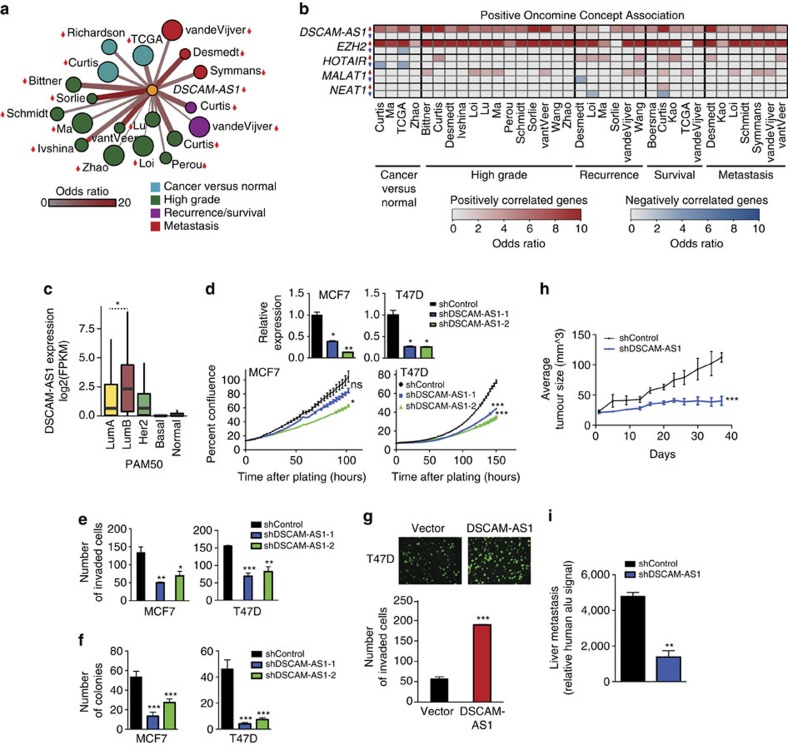
DSCAM-AS1 is implicated in cancer aggression clinically and in cell lines.(a) Cytoscape depiction of the overlap between the 150 genes most positively correlated with DSCAM-AS1 and clinical signatures from Oncomine27 for breast cancer clinical outcomes (i.e., recurrence, survival and metastasis), high cancer grade, and cancer versus normal. All significant associations with an odds ratio >6 are shown (Fisher's P value <1E−4). Size of node reflects the size of the gene signature, and the thickness/redness of the line represents the magnitude of the odds ratio. (b) Heatmap displaying the overlap between the top 150 genes correlated to DSCAM-AS1, EZH2, HOTAIR, MALAT1 and NEAT1 and the genes positively associated with various breast cancer clinical signatures (see above). For each gene, the top row depicts the odds ratio for the positively correlated genes (red), and the bottom row represents the odds ratio for the negatively correlated genes (blue). The first name of the author for each clinical study is listed. (c) Expression of DSCAM-AS1 from breast cancer RNA-seq by PAM50 classification (n=946). Luminal B expression is significantly greater than Luminal A (Student's t-test, P=0.006) (d) Incucyte proliferation assay performed following knockdown of DSCAM-AS1 using two independent shRNAs. Degree of knockdown determined by qPCR shown above. Error bars represent the s.e.m. for three biological replicates. *P<0.01, **P<0.001, ***P<0.0001, NS: P>0.01 comparing to shControl for each condition via Student's t-test. (e) Invasion assay following shRNA knockdown of DSCAM-AS1 using Matrigel coated Boyden chamber assay. Error bars represent the s.e.m. for three biological replicates. *P<0.01, **P<0.001, ***P<0.0001 comparing to shControl for each condition via Student's t-test. (f) Soft agar colony formation assay following shRNA knockdown of DSCAM-AS1. Error bars represent the s.e.m. for three biological replicates. ***P<0.0001 comparing to shControl for each condition via Student's t-test. (g) Invasion assay following overexpression of DSCAM-AS1 and LacZ control. Error bars represent the s.e.m. for three biological replicates. Representative invasion images shown above. ***P<0.0001, comparing to vector overexpression via Student's t-test. (h) Mouse xenograft study of tumour growth for T47D cells with shRNA knockdown of DSCAM-AS1. Xenografts with shRNA knockdown of DSCAM-AS1 (n=24) exhibited reduced growth when compared to control shRNA knockdown (n=26). Error bars represent the s.e.m. for all xenografts used. ***P<0.0001, comparing to shControl via Student's t-test. (i) Assessment of xenograft metastasis to liver by human Alu PCR, which detects the human cancer cells in the mouse liver. Error bars represent the s.e.m. for three biological replicates. **P<0.001 comparing with shControl via Student's t-test. NS, not significant.